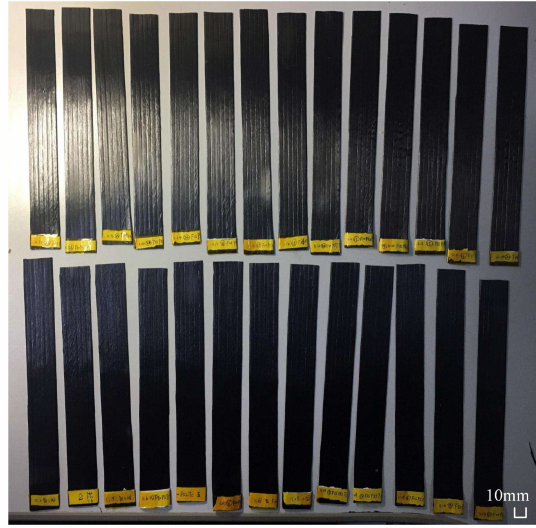
Figure 5. Twenty-seven groups of samples made by